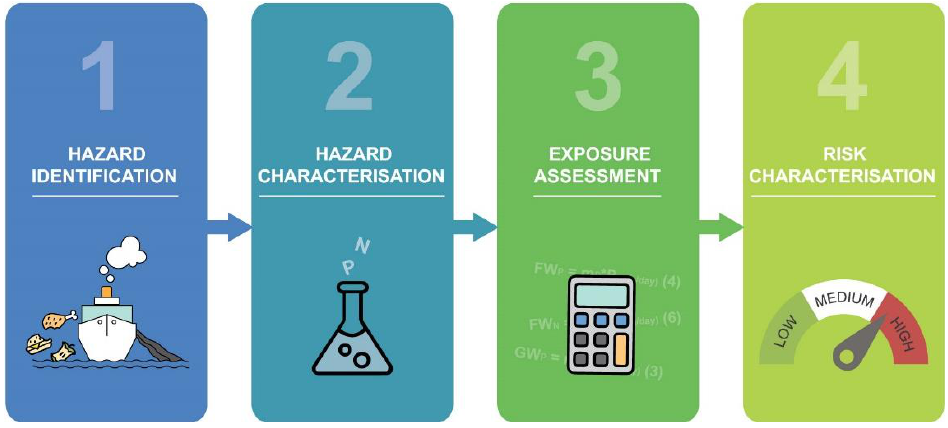
Figure 2. A visual representation of a four-stage operational model for assessment of pollution risk arising from sea environment eutrophication. We adopted the presented approach [17] to identify and characterize food waste-related hazards, assess exposure, and describe pollution risks.